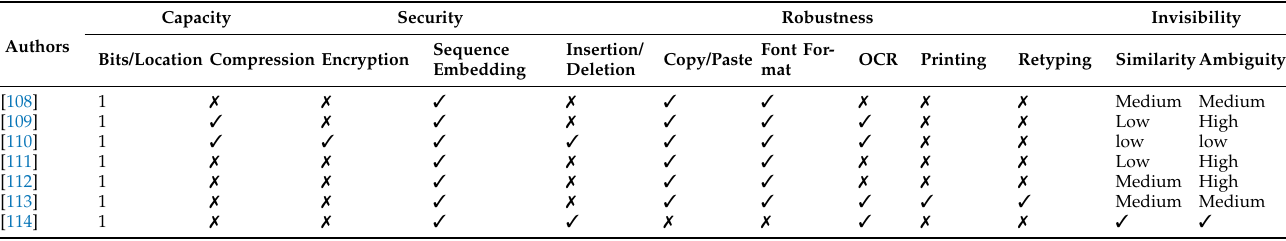
Table 26. Evaluation of hybrid method based on invisibility and robustness and